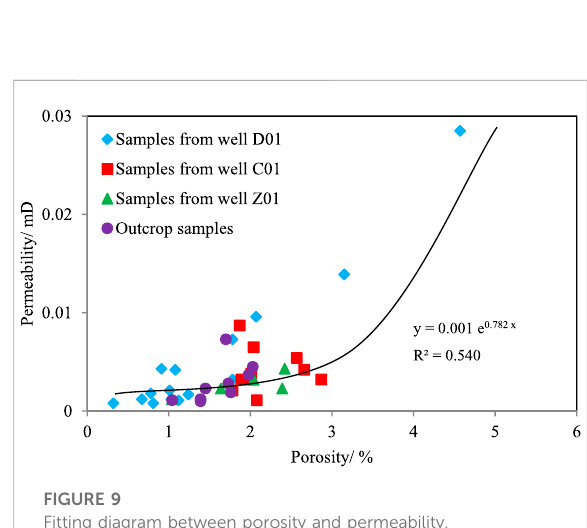
FIGURE 9 Fitting diagram between porosity and